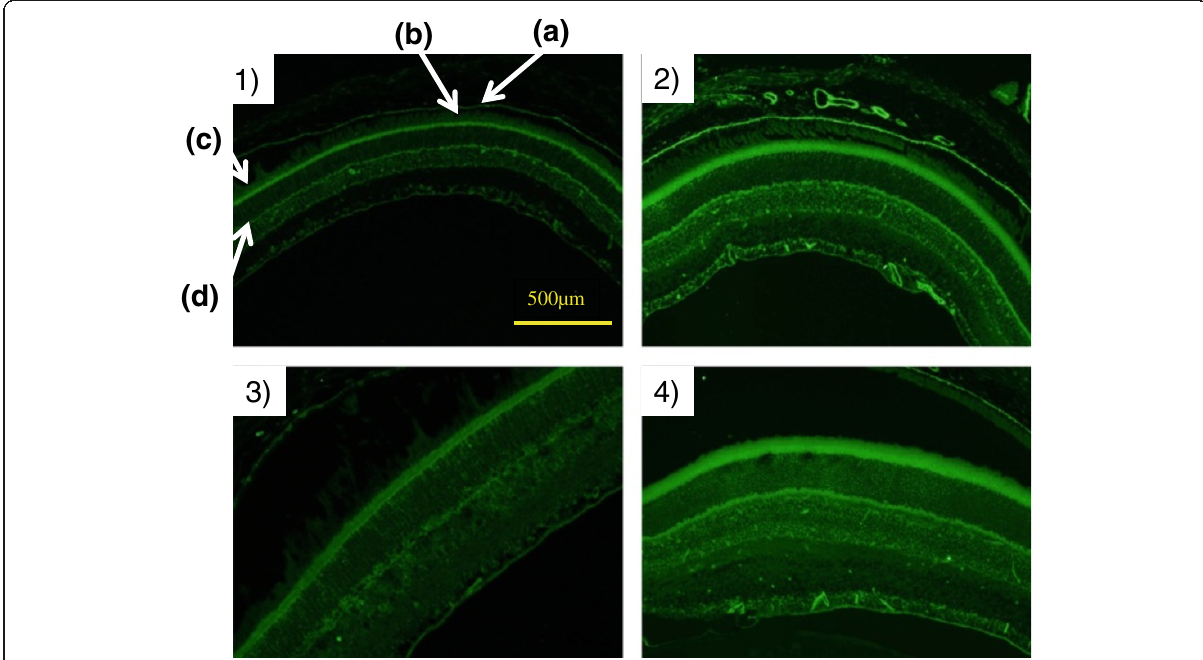
Figure 8 Effects of CTS and THA on VEGF expression in the retinal tissue in db/db mice. The retinal tissues were obtained from the animals perfused with paraformaldehyde as described in the text. The arrows a, b, c, and d represent pigment epithelium, outer segments, inner segments, and outer plexiform layers, respectively. VEGF-positive portions were identified by VEGF immunostaining. Photos 1, 2, 3, and 4 were from the retinal tissues of m/m control, vehicle-treated db/db , CTS (750 mg/kg per day)-treated db/db , and THA (2.5 mg/kg per day)-treated db/db group, respectively. Arrows a, b, c, and d represent pigment epithelium, outer segments, inner segments, and outer plexiform layer,